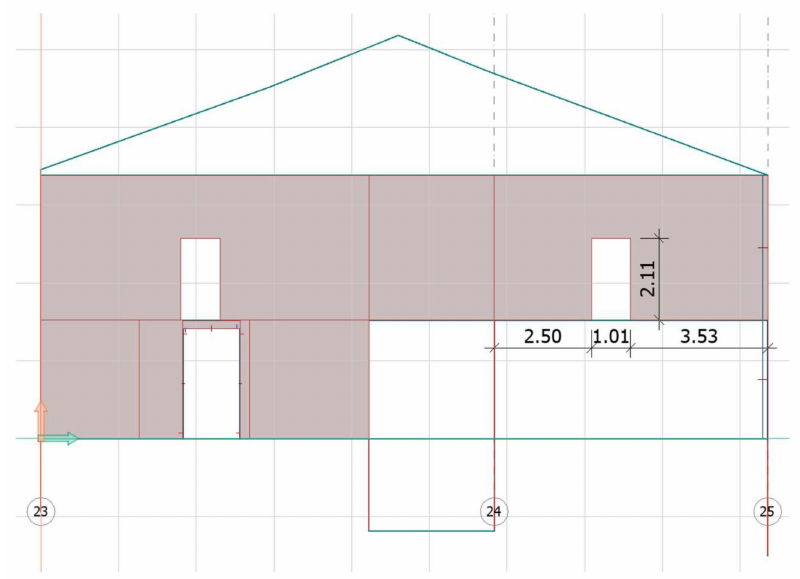
Figure 17. EW after cutout opening in second story (under attic) between axes 24 and 25 (unit: m).